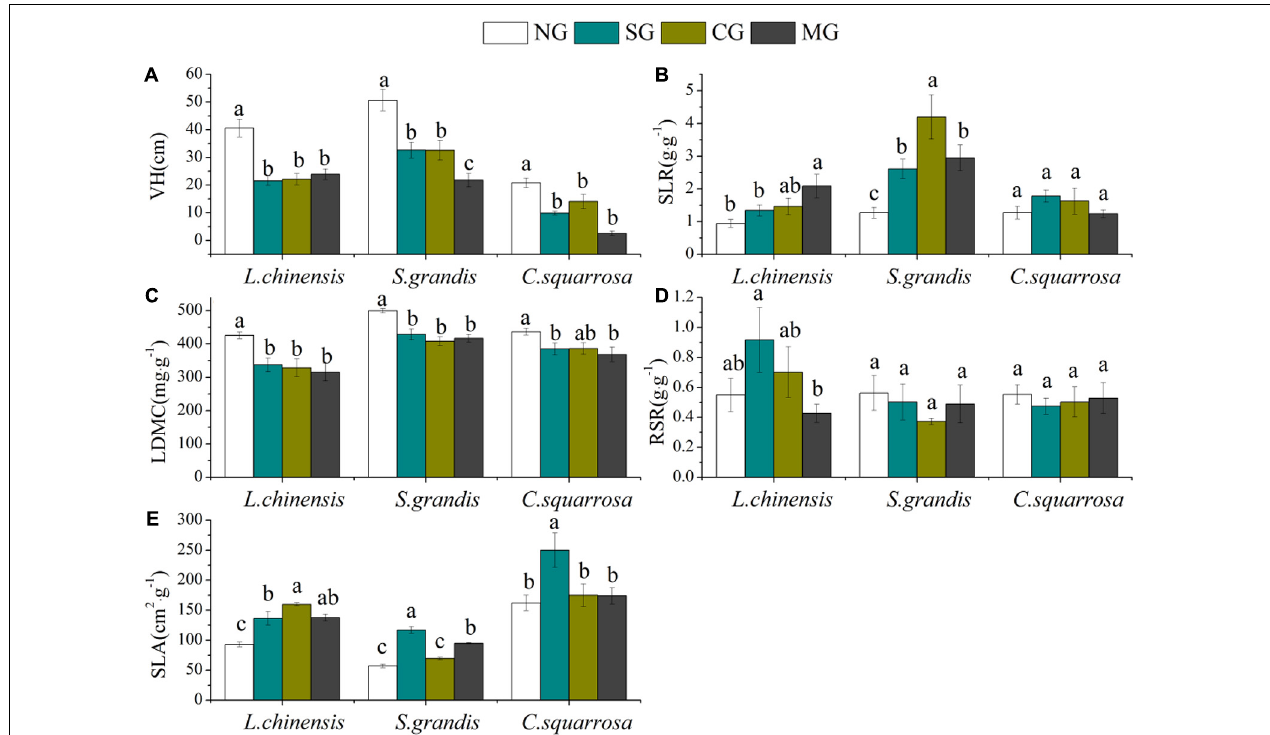
FIGURE 1 | Morphological traits of dominant species in different plots (SG, sheep grazing; CG, cattle grazing; MG, mixed grazing with cattle and sheep; NG, no grazing) showing (A) Vegetative height, (B) Stem leaf ratio, (C) Leaf dry matter content, (D) Root shoot ratio, (E) Specific leaf area. In each graph, means with the same lowercase letters are not significantly different among plots ( P > 0.05); means with different lowercase letters are significantly different among plots ( P < 0.05). Capped lines represent ± standard